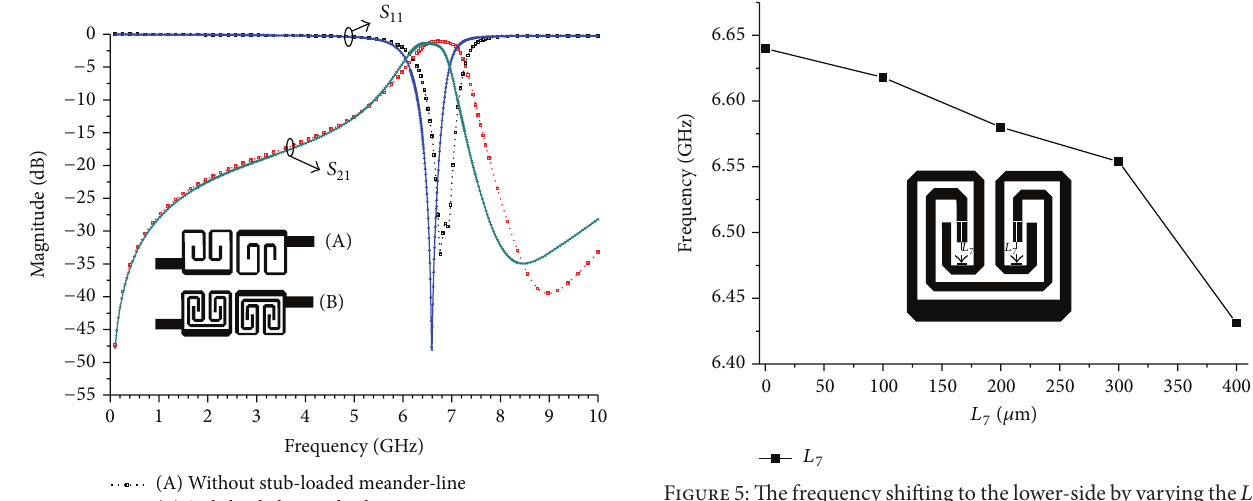
Figure 5: The frequency shifting to the lower-side by varying the 𝐿 7 overlapping open-ends of the meandered